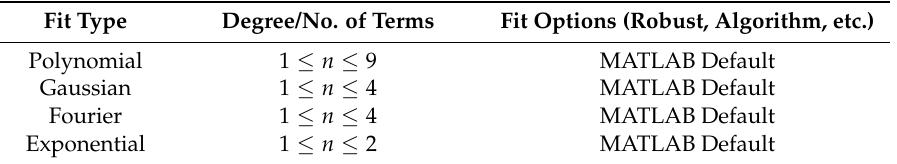
Table 1. Curve fit types and parameters.